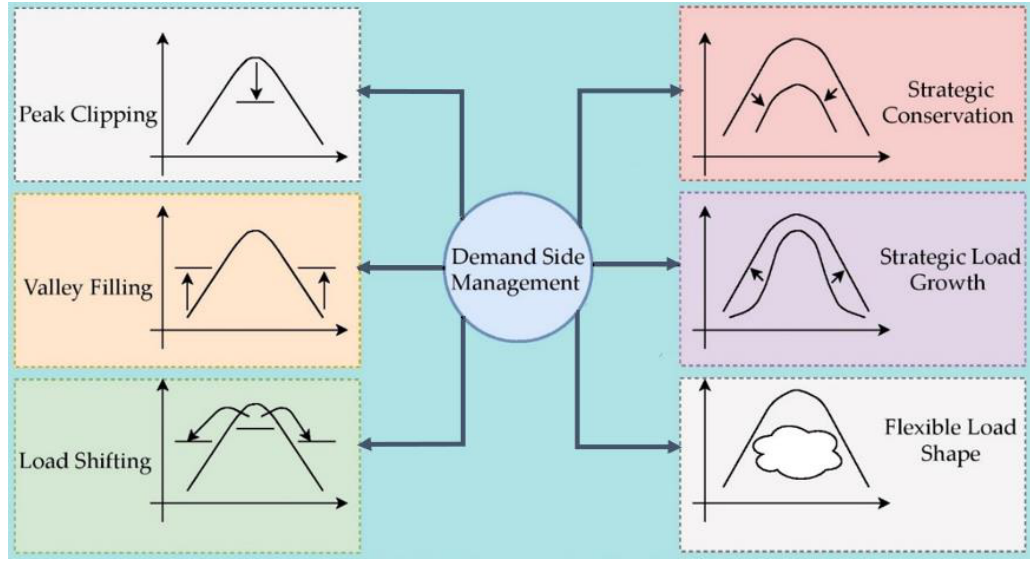
Figure 11. The six different demand-side management approaches are used in the smart grid (Redrawn with permission from [91], 2014, Elsevier).